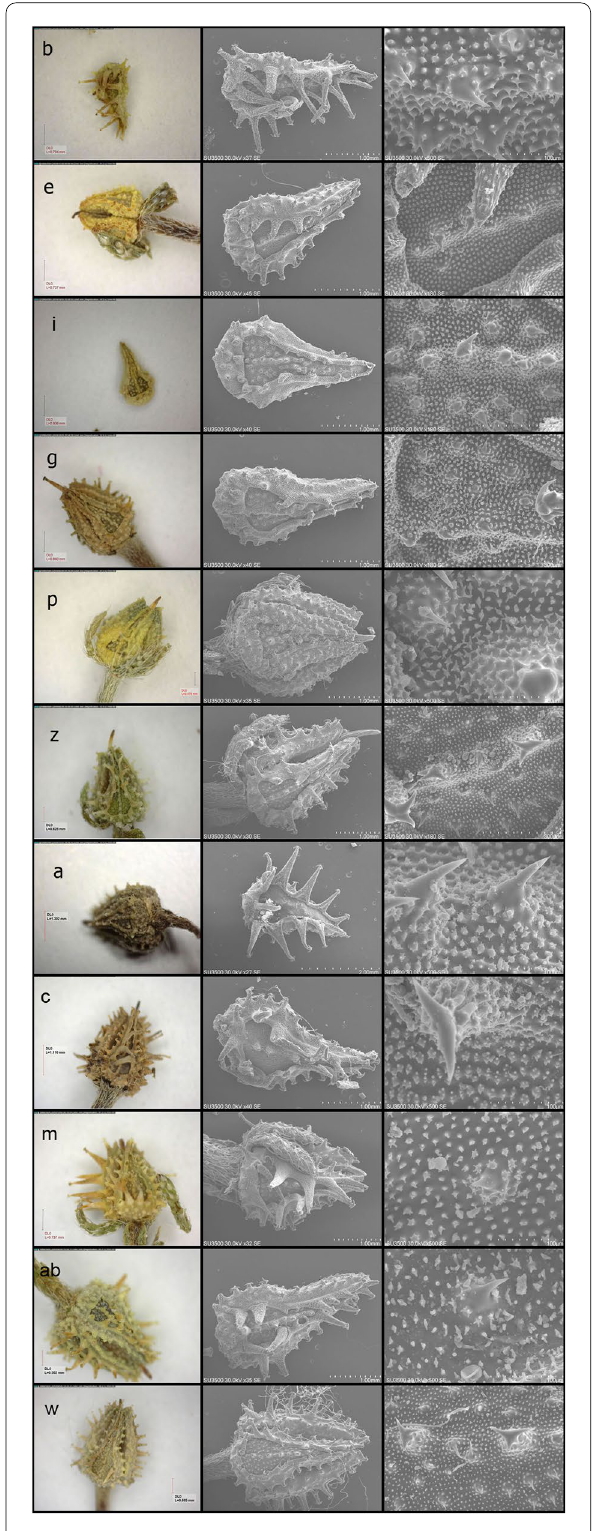
Fig. 3 nutlet morphology in the different specimens of Lappula microcarpa and lappula barbata . The details of the studied specimens are in accordance with Table 1 ( L. microcarpa codes: b, e, I, g, p, z, a ; L. barbata : c, m, Ab, w)